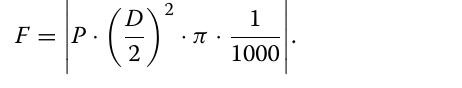
10°, b θ inc 20°, c θ inc = = =